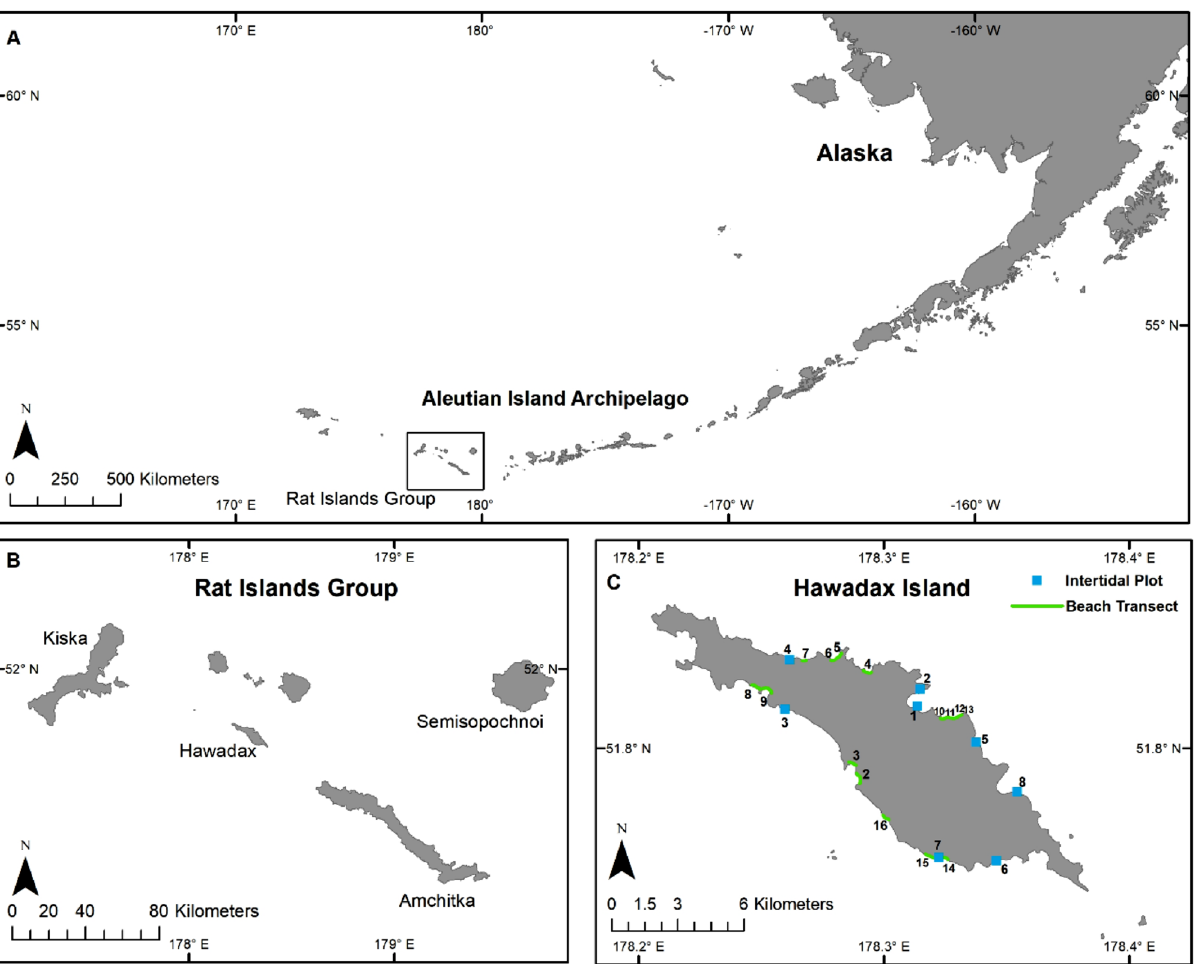
Figure 1. The ( A ) central Aleutian Archipelago, Alaska, USA contains the ( B ) Rat Islands Group, including Hawadax Island. The ( C ) intertidal plots and beach transects surveyed on Hawadax Island. Intertidal plot 6 was only surveyed in 2008 and 2013 35